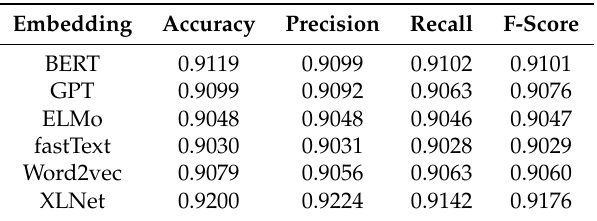
Table 1. The performance of models with different